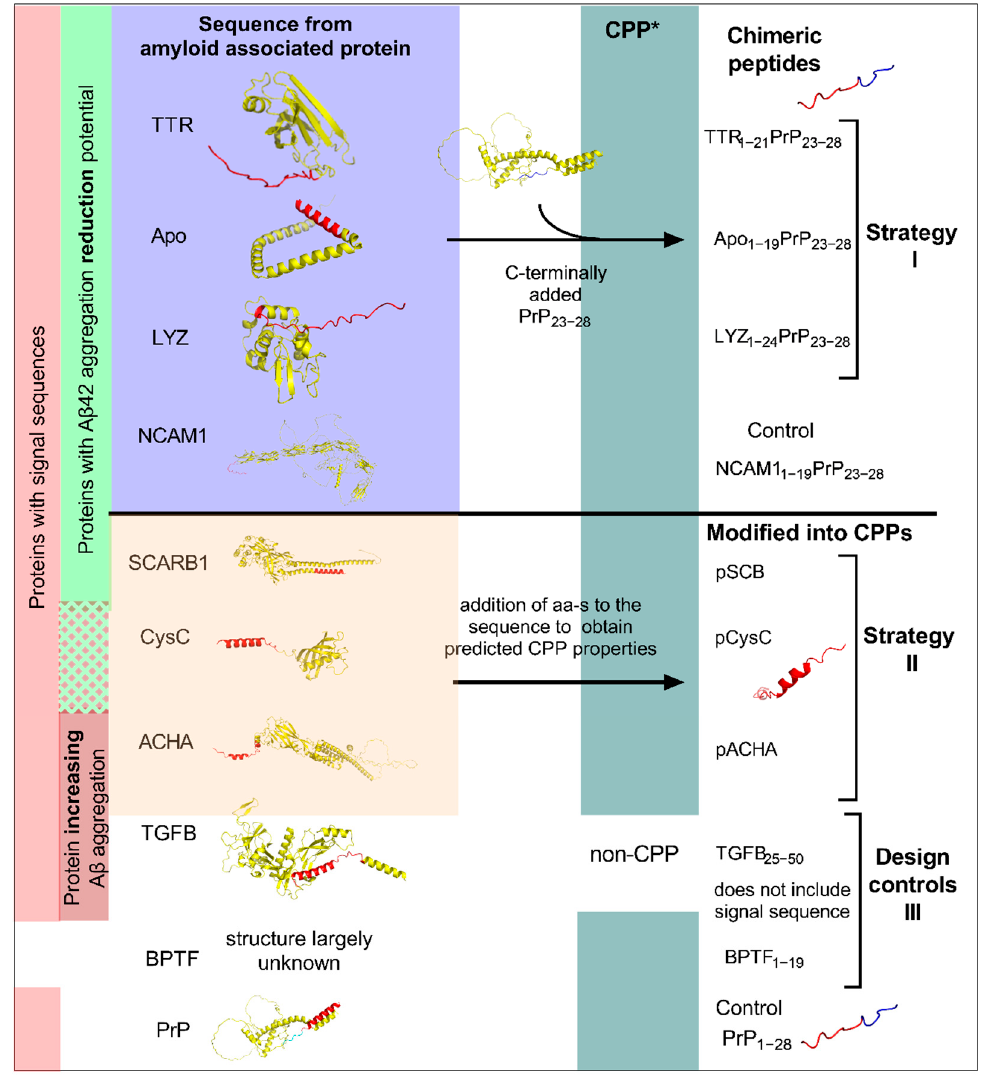
Figure 1. Structures of proteins used for the design of the peptides, design principle of anti-aggregation peptides, and controls. Protein identificators: mouse Transthyretin, TTR–P07309, 2QPF; mouse Apolipoprotein A-II, Apo-P09813; human Lysozyme C, LYZ–P61626; mouse Neural cell adhesion molecule 1, NCAM1– P13595; mouse major prion protein, PrP P04925; mouse Scavenger receptor class B member 1, SCARB1–Q61009; mouse Cystatin-C, CysC–P21460; mouse Neuronal